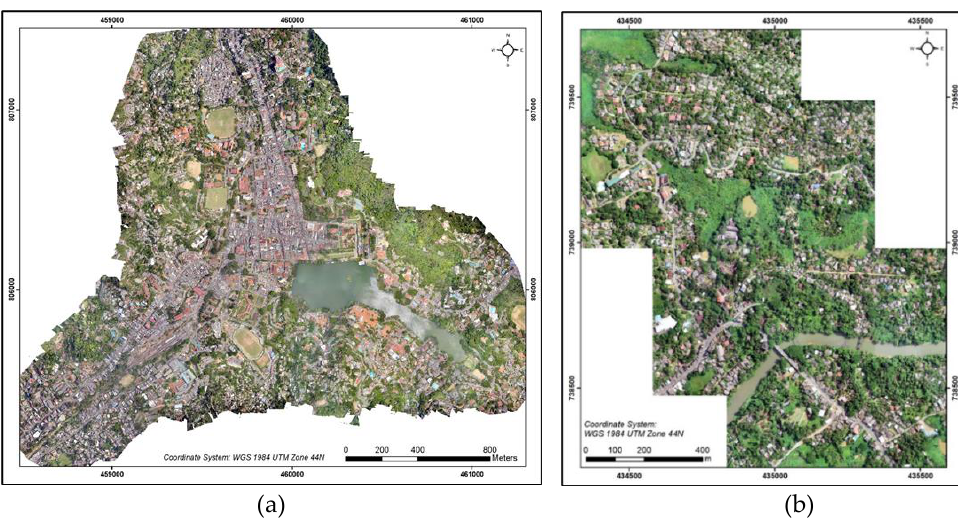
Figure 3. UAV orthomosaic of Kandy, Sri Lanka (a) and UAV orthomosaic of Ratnapura, Sri Lanka